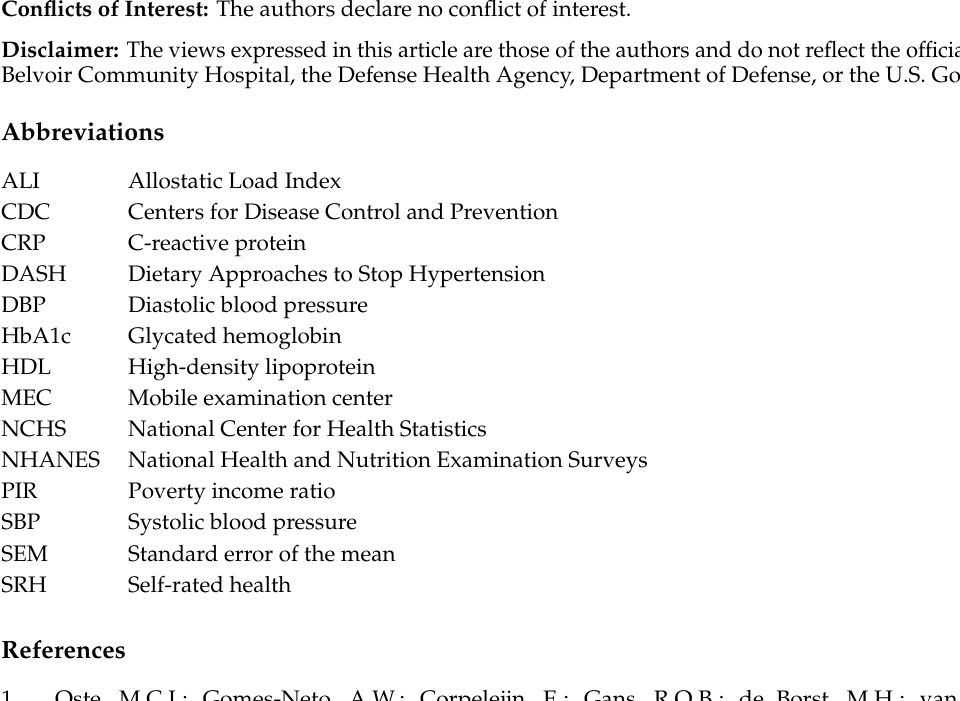
Table S1: DASH diet scoring system, Table S2: Allostatic Load